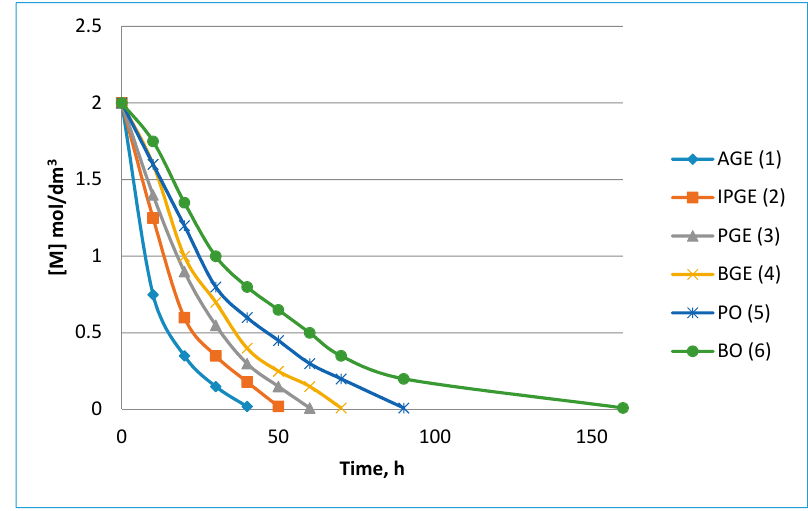
Figure 1. Monomer concentration vs. time of polymerization initiated with K-DPG activated by 18C6 in THF solution; [M] o = 2.0 mol/dm 3 ; [I] o = [18C6] o = 0.1 mol/dm 3 ; AGE ( 1 ), IPGE ( 2 ), PGE ( 3 ), BGE ( 4 ), PO ( 5 ), and BO ( 6 ).